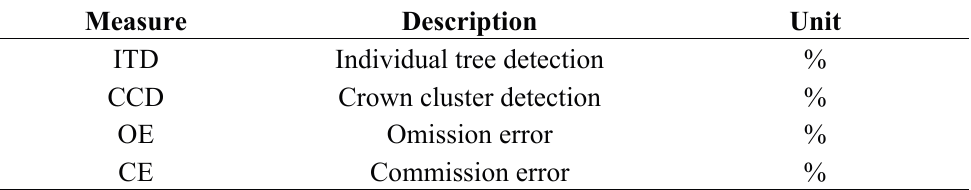
Table 6. Definitions of measures used for detection accuracy